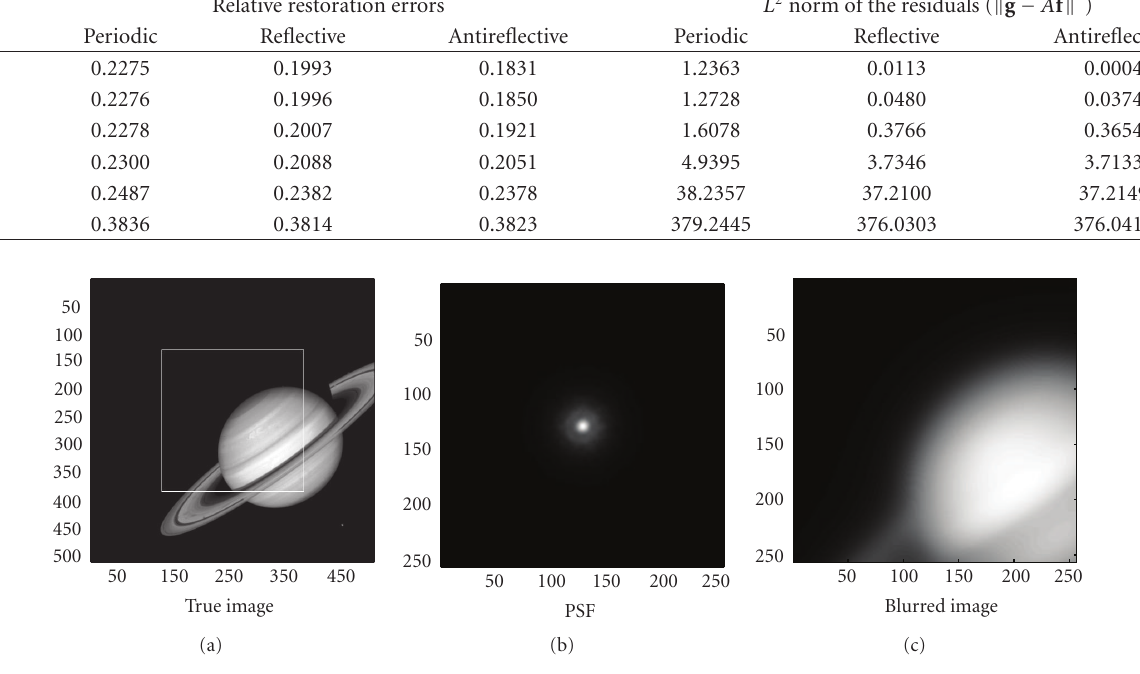
Figure 4: Test II: true image, PSF, and the blurred image without noise.